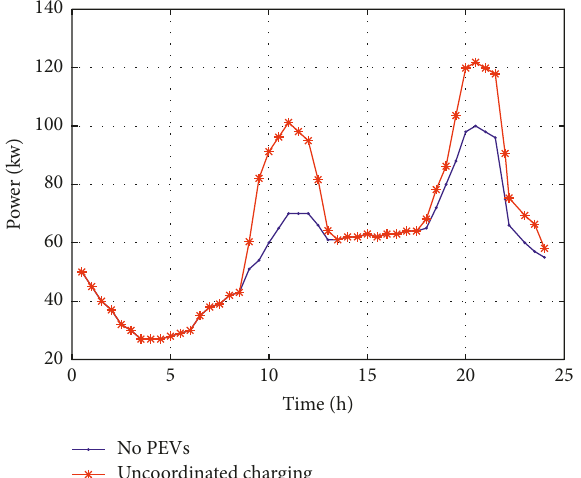
Figure 5: The daily load curve of a branch.